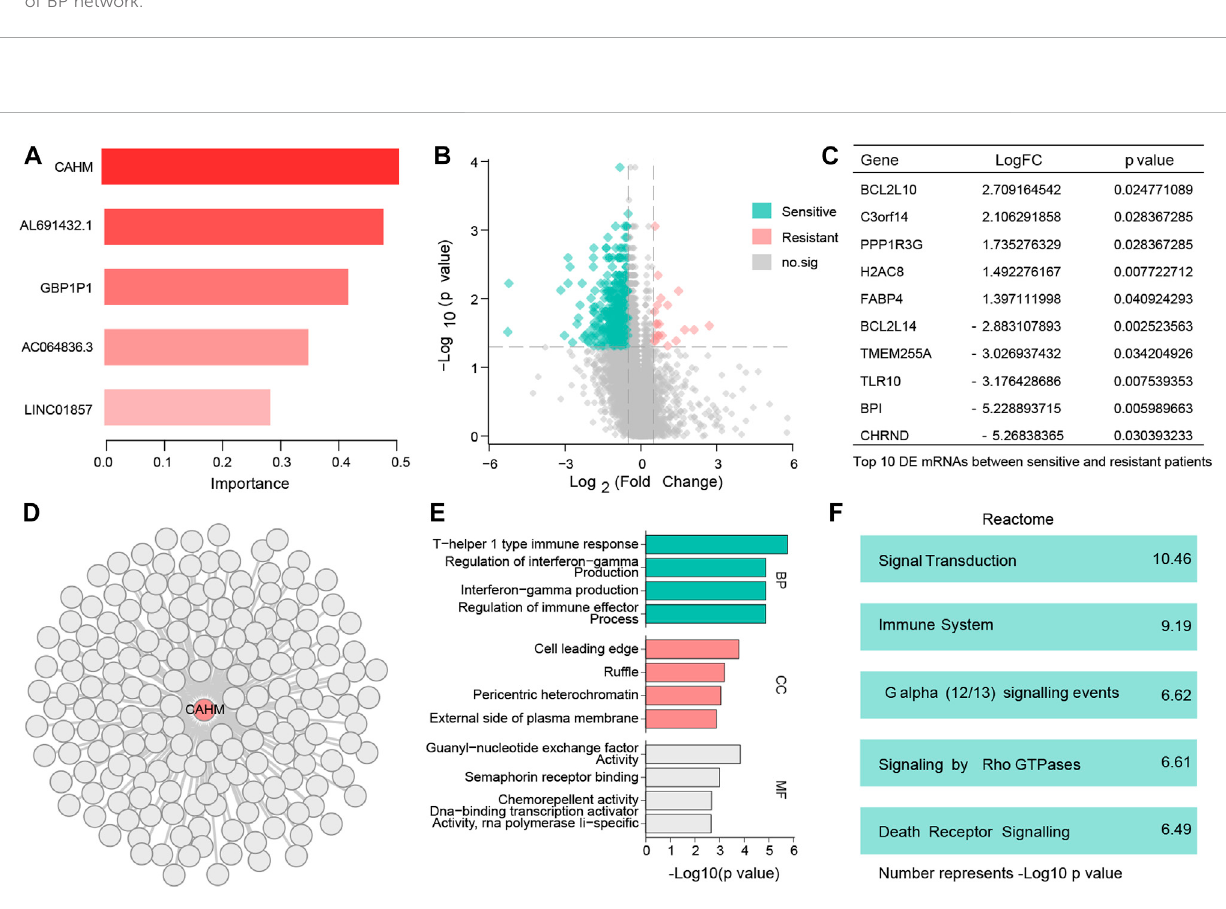
BP network validate predict ability of fi ve chemotherapy related LncRNAs. (A) BP neural network diagram, shown from left to right respectively are theinputlayer,hiddenlayer5nodes,outputlayer. (B) ROCmodelveri fi edtheaccuracyofBPnetwork,andAUCvaluewas0.976,indicatinghighaccuracy of BP network.